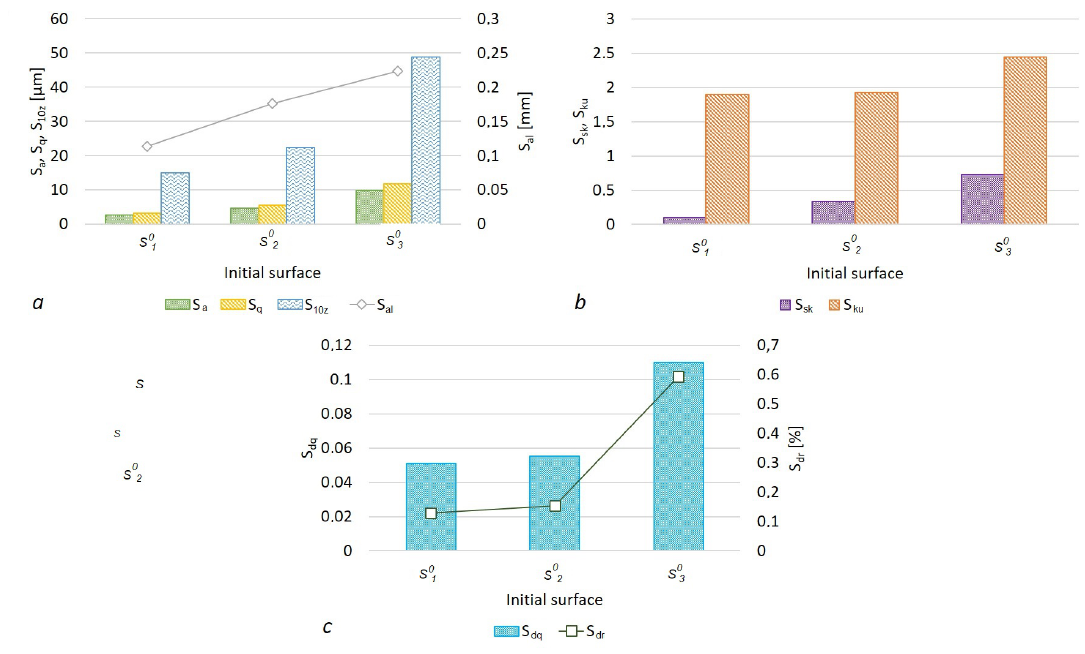
Figure 3. 3D texture parameters of the original surfaces. ( a ) Amplitude parameters S a , S q and S 10 z , and spatial parameter S al . ( b ) Hybrid parameters S dq and S dr . ( c ) Surface skewness S sk and kurtosis S ku